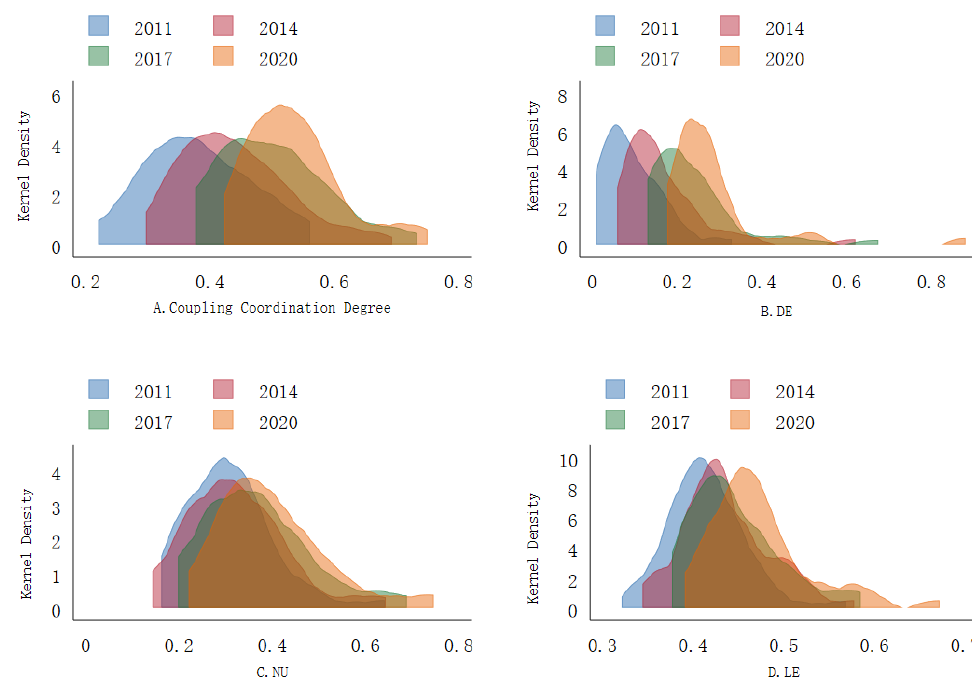
Figure 6. Kernel density analysis of the coupling coordination degree and the subsystems. (Subfig- ure A represents the kernel density change of coupling coordination degree. Subfigure B represents the kernel density change of DE. Subfigure C represents the kernel density change of NU. Subfigure D represents the kernel density change of LE.)